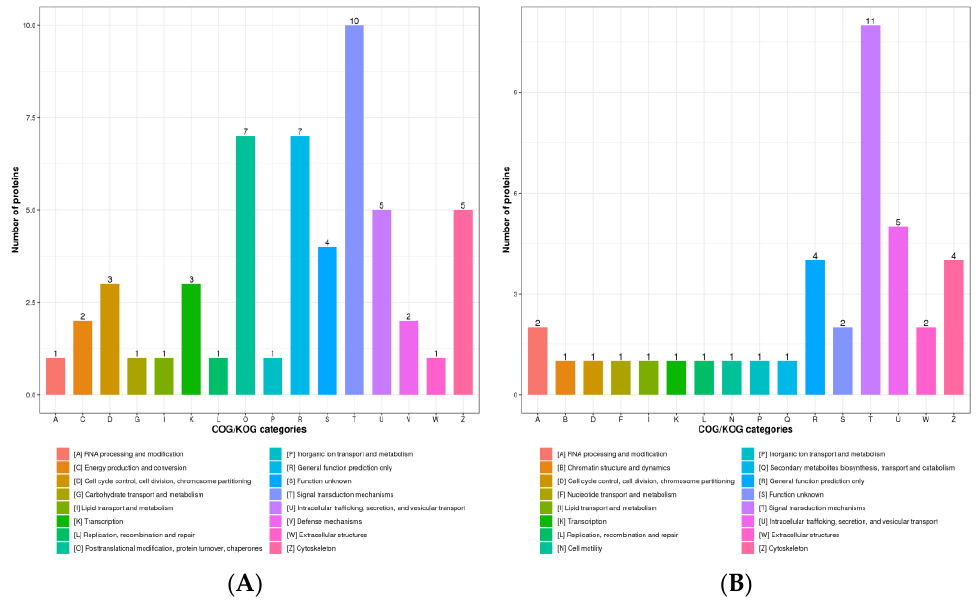
Figure 3. The COG/KOG classification of DPPs. ( A ) The COG/KOG classification of up-regulated DPPs. ( B ) The COG/KOG classification of down-regulated DPPs. The x-axis is the COG/KOG cate- gories and the y-axis is the number of